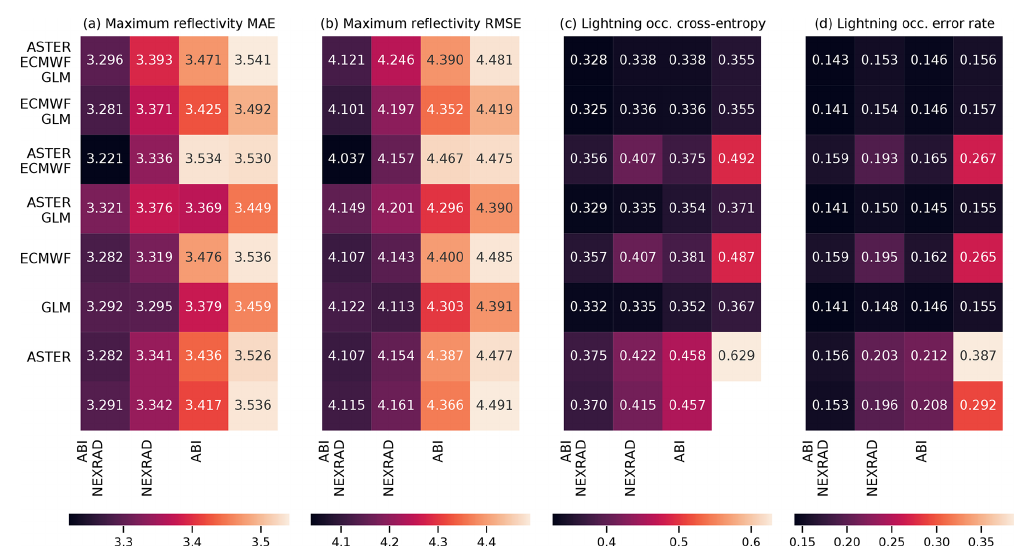
Figure 8. The results of exclusion experiments on the MAXZ and LIGHTNING-OCC predictands. Each square in panels (a) – (d) corresponds to a combination of data sources, which can be found by combining the sources listed for the row and the column. For example, the top left square of each panel shows the error metric obtained using all five data sources, while the second column of the second row shows the metric for ECMWF, GLM and NEXRAD data. The predictand and the error are shown on top of each panel; RMSE indicates the root-mean-square error and MAE the mean absolute error. In panels (a) and (b) , the bottom right corner shows the result obtained with the bias-corrected persistence assumption (see Sect. 4.1), while in panel (d) , the bottom right corner shows the baseline climatological occurrence. The results for LIGHTNING-OCC are shown for the 30–60min time interval.